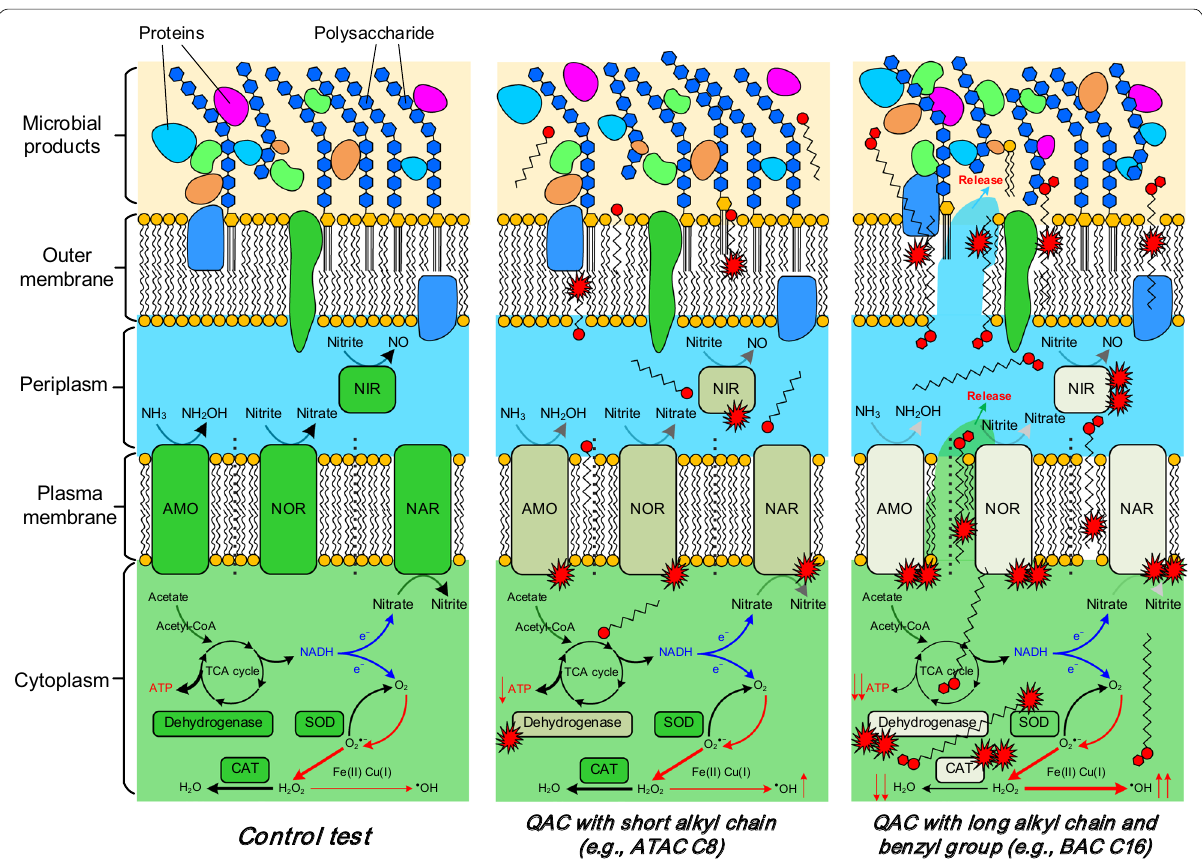
Fig. 5 A schematic representation of the acute toxicity induced by the transient shock loads of different kinds of QACs. The dash lines in plasma membranes indicate that AMO, NOR, NAR and NIR might be assigned to different phylotypes. The gradually lightened color of AMO, NOR, NAR, NIR, dehydrogenase, and CAT in the three panels indicates an increased negative influence. The line thickness of the arrows associated with ATP and H 2 O 2 (transformed to either H 2 O or ⋅ OH) is proportional to their